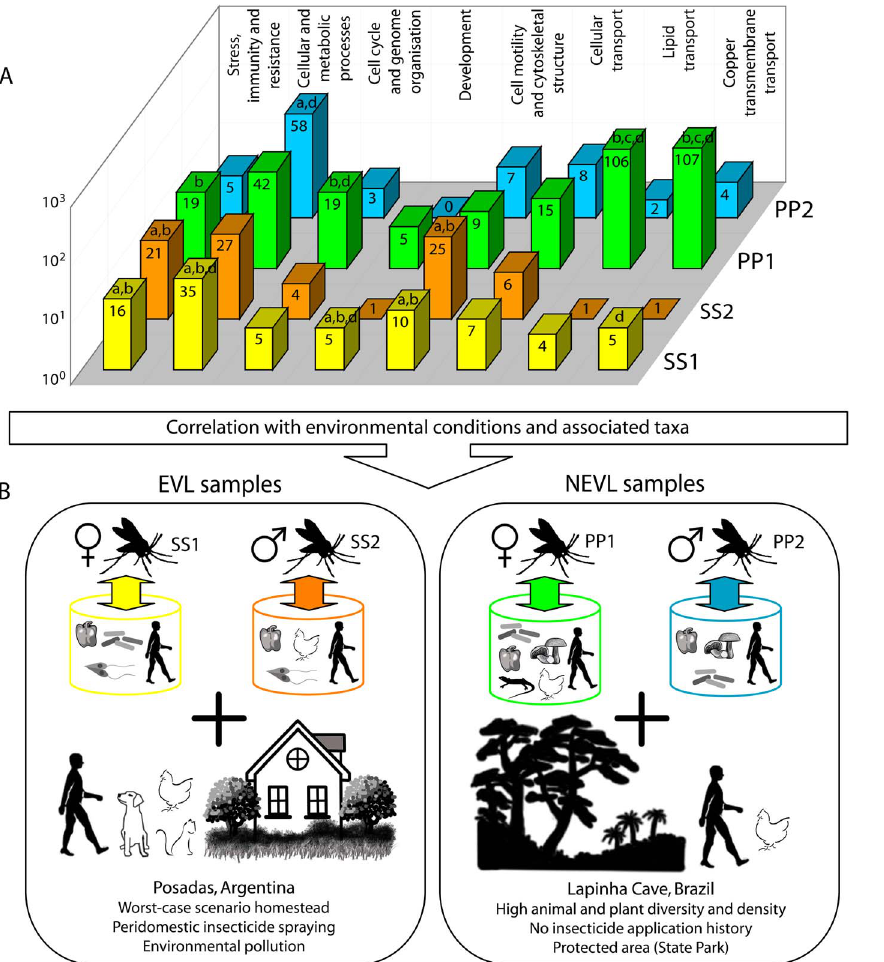
Figure 2. Sand flies as environmental samples: expression profiles in EVL and NEVL sand flies correlated with environmental conditions and taxa previously identified in these samples. This figure integrates data from the function categories identified in these wild EVL and NEVL sand flies with sampling site characteristics and taxa previously found in these same samples [22]. Figures are only schematic and not an exact representation of either the sampling sites, phlebotomine sand flies or identified taxa. A) Shows the function categories that the transcripts were assigned to in all the samples and the number of transcripts assigned to each function category for each sample. Values are expressed on a logarithmic scale and indicated for each sample on the corresponding bar. Significant differences in the number of transcripts in each category between samples (Fisher’s Exact Test; p , 0.05) are indicated as: a, significantly overrepresented with respect to PP1; b, significantly overrepresented with respect to PP2; c, significantly overrepresented with respect to SS1; and d, significantly overrepresented with respect to SS2. B) The top part shows a schematic of the sandflies (female or male) from both locations and of the taxa we previously identified in all four samples [22]. Barrels group the taxa found in each sample. Previously identified taxa in SS1: bacteria, protists, metazoans (human) and plants; SS2: protists, metazoans (human and chicken) and plants; PP1: bacteria, fungi, metazoans (human, chicken and lizard) and plants; and PP2: bacteria, fungi, metazoans (human) and plants. Taxa are represented schematically and the particular species identified for each taxonomical group are not shown, except in the case of metazoans. The bottom part shows the most significant ecological characteristics of both capture site locations in Argentina and Brazil, Posadas and Lapinha Cave, respectively. Only those animal species confirmed in the sampling sites in both locations at the time of sampling were represented schematically. EVL sampling site (Posadas, Argentina): human, dog, cat and chicken; NEVL sampling site (Lapinha Cave, Brazil): human and chicken. SS1 (indicated in yellow): EVL adult female Lu. longipalpis (Posadas, Argentina); SS2 (indicated in orange): EVL adult male Lu. longipalpis (Posadas, Argentina); PP1 (indicated in green): NEVL adult female Lu. longipalpis (Lapinha Cave, Brazil); PP2 (indicated in pale blue): NEVL adult male Lu. longipalpis (Lapinha Cave,